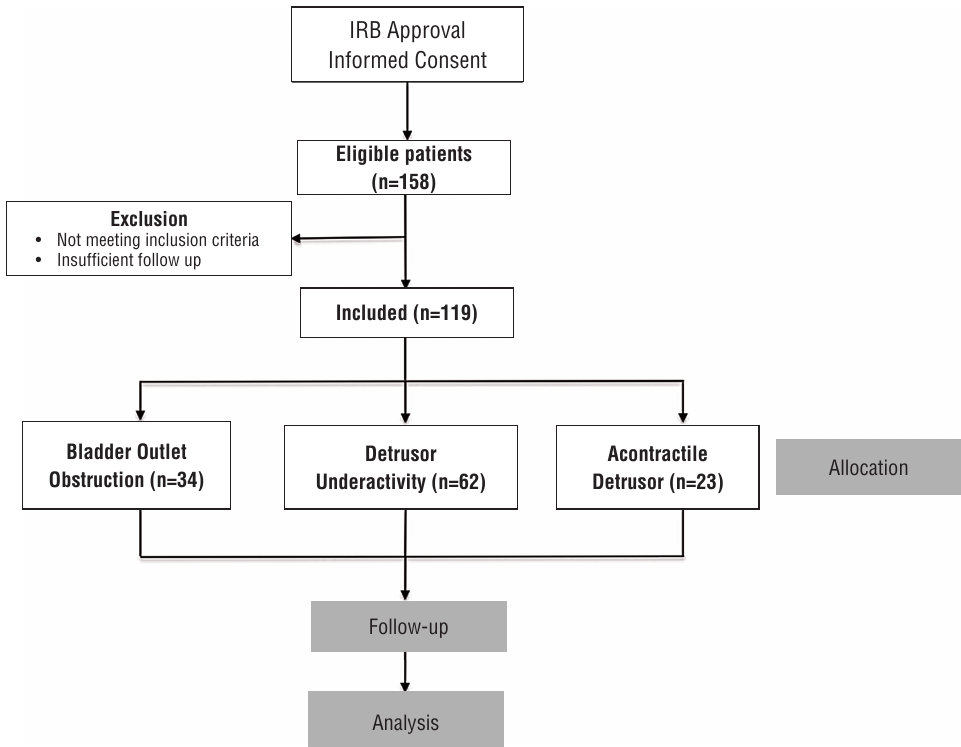
figure 1 - Patient selection.